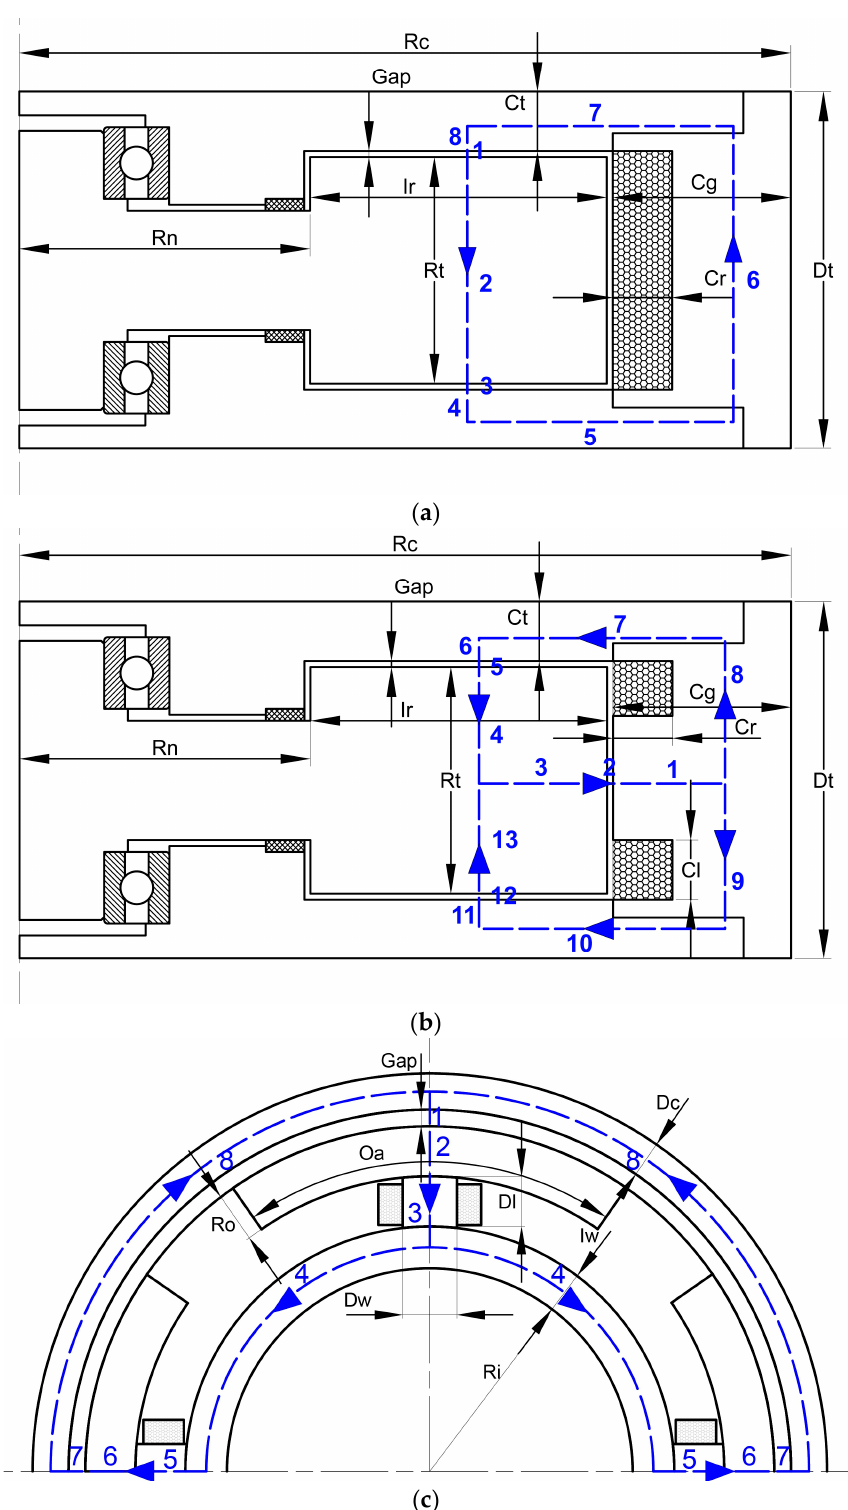
Figure 4. Diagram of the operating principle of MR-TVAs: ( a ) axial single-coil con fi guration; ( b ) axial multi-coil con fi guration; ( c ) circumferential con fi guration.